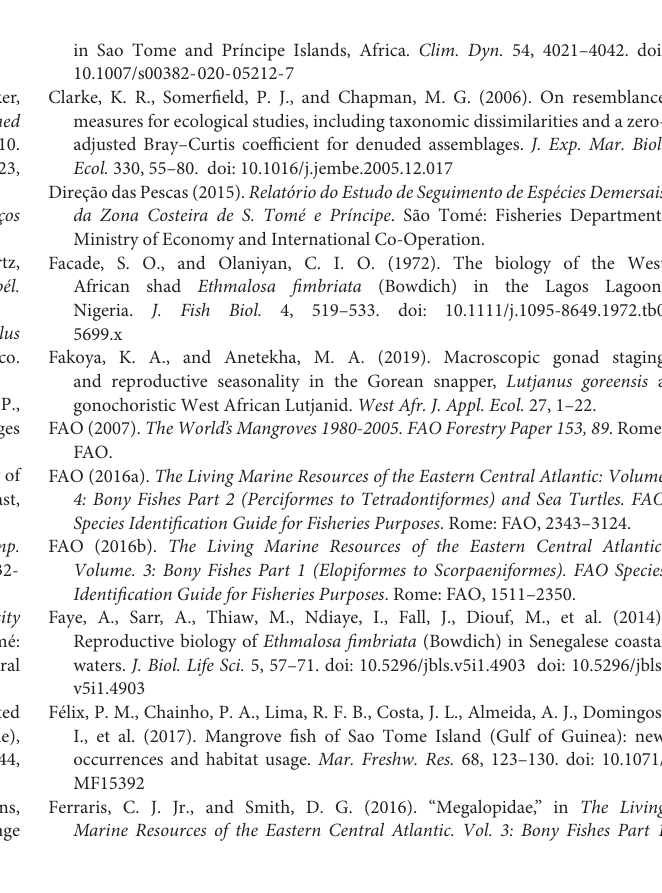
Supplementary Figure 1 | Average water column depth at the four sampling sites in the mangrove system (upper, middle, lower, and outer) during the rainy and dry seasons and spring or neap tides. The points represent the average depth over the 3 days measured for each tidal situation and respective standard error. Supplementary Figure 2 | Salinity at the four study sites in the mangrove system (upper, middle, lower, and outer) during the rainy and dry seasons and spring or neap tides. The points represent the average salinity over the 3 days measured for each tidal situation and respective standard error. Supplementary Figure 3 | Water temperature at the four study points in the mangrove system (upper, middle, lower, and outer) during the rainy and dry seasons and spring or neap tides. The points represent the average temperature over the 3 days measured for each tidal situation and respective standard